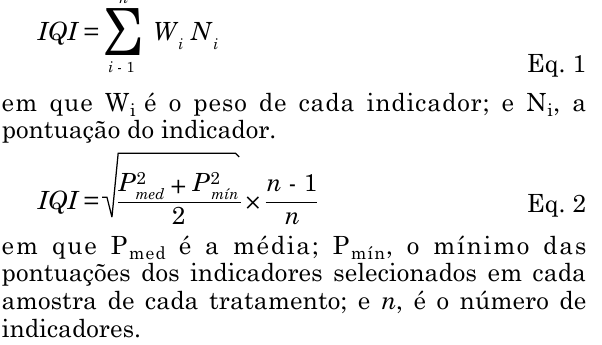
ŷ = - 0,0534 + 0,7819 x R² =